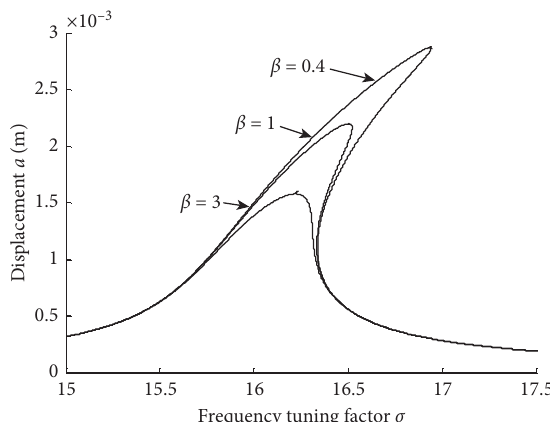
Figure 4: Amplitude frequency characteristics of different initial displacement.